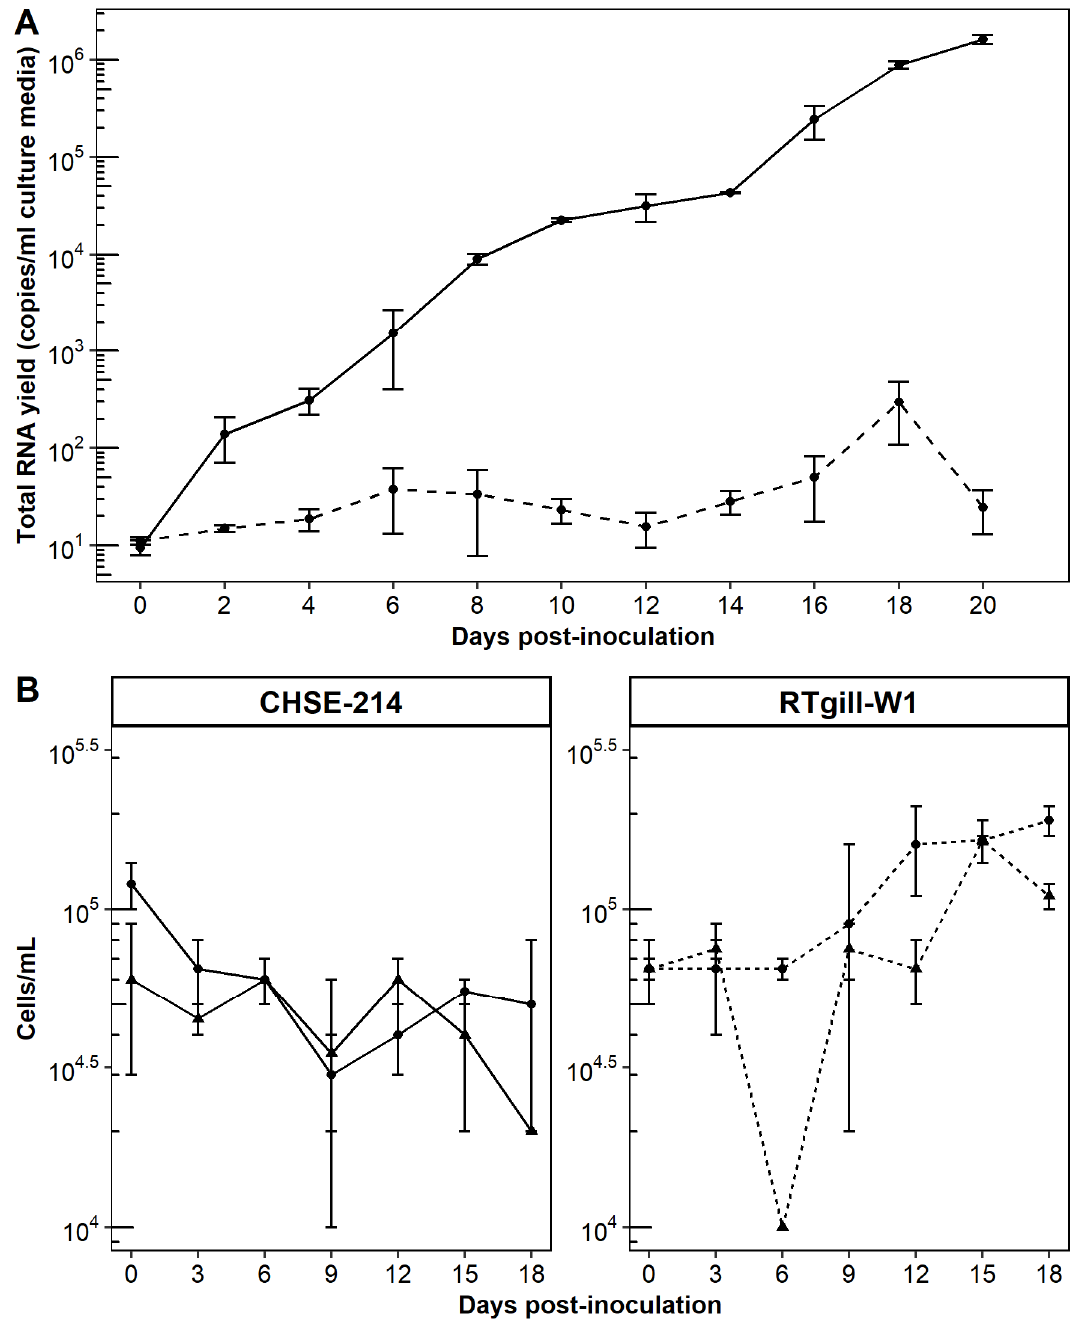
Figure 7. ( A ) CTV-2 replication in CHSE-214 ( - ) and RTgill-W1 (—) cells. Error bars denote standard error of the mean for duplicate samples. ( B ) Viable cells/mL in infected ( ● ) and uninfected ( ▲ ) CHSE and RT-gill cells.